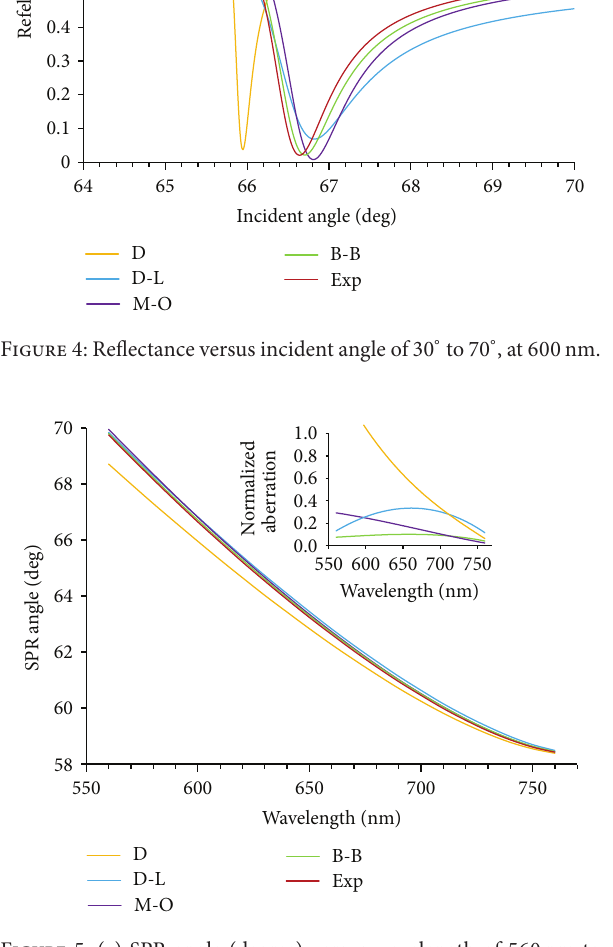
Figure 5: (a) SPR angle (degree) versus wavelength of 560 nm to 760 nm. Inset: error value at SPR angle for the same wavelength.